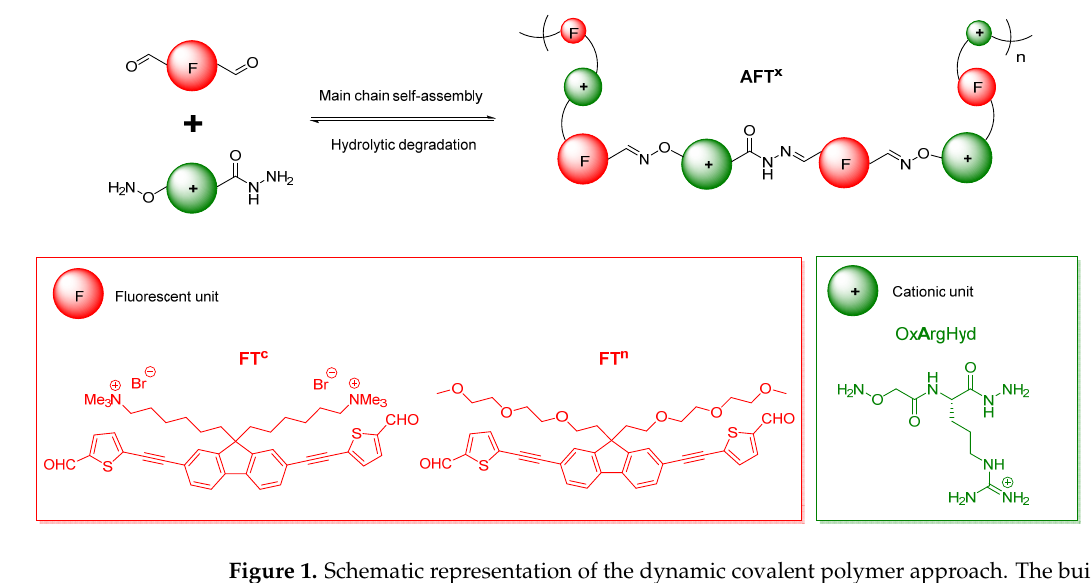
Molecules 2022 , 27 , x FOR PEER REVIEW